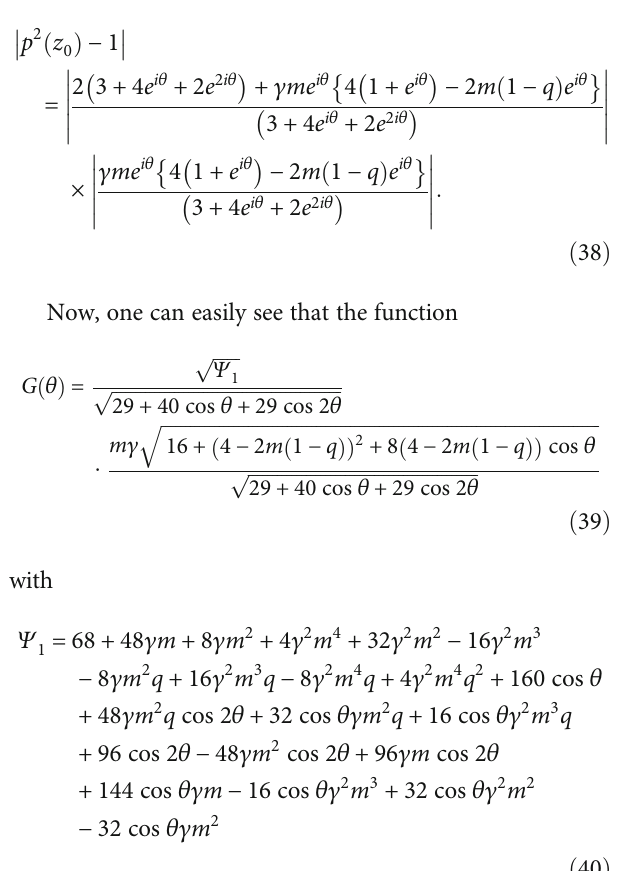
ffiffiffiffiffiffiffiffiffiffiffiffiffiffiffiffiffi 1 + w z ð Þ